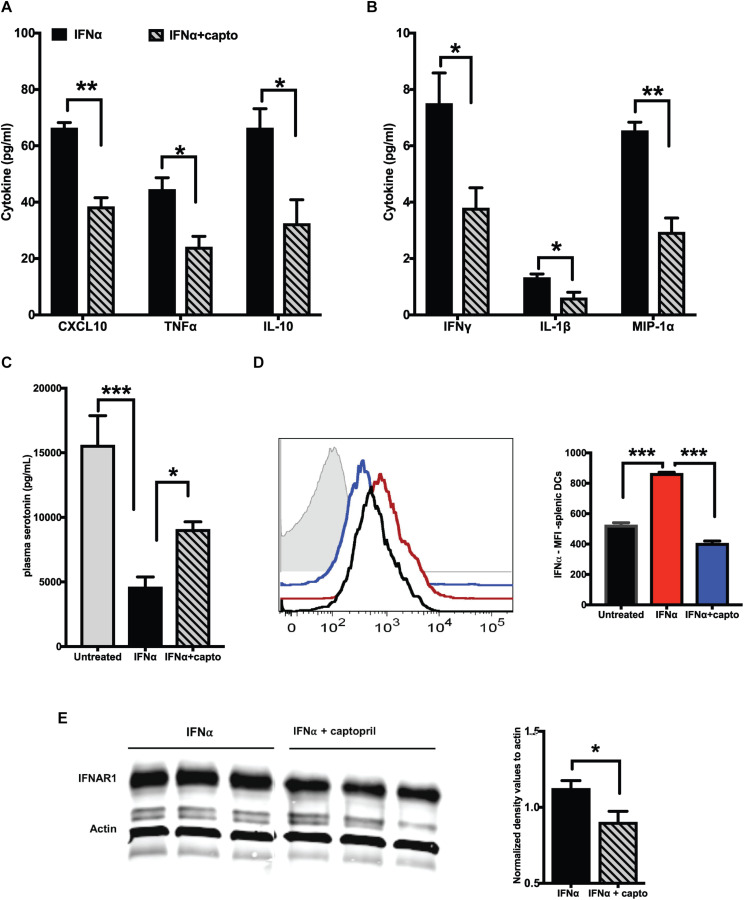
Captopril reduces IFN responsive protein expression. Plasma from MRL/lpr mice induced with exogenous IFNα and treated with captopril for 2 weeks were analyzed for cytokines and chemokines using MSD multiplex ELISA kit. Significantly different cytokines and chemokines are represented, (A) >10 pg/ml and (B) <10 pg/ml (n = 4/group). (C) Serotonin levels in plasma of IFNα induced MRL/lpr mice was measured using ELISA. (D) Splenocytes of IFNα treated MRL/lpr mice were harvested, stained for intracellular IFNα, gated and analyzed on CD11c + cells. Median fluorescence intensities (MFI) are represented as histograms on the left and the corresponding colors for the different groups indicated in the bar graph on the right (n = 4/group). Unstained control is shown in gray in the histogram. (E) Spleen lysates of exogenous IFNα treated MRL/lpr mice were analyzed by western blotting to detect IFNAR1 protein. Actin was used a loading control. Band intensities were analyzed using ImageJ software and normalized values are represented in the graph. Unpaired t test statistical analysis was performed and p < 0.05 was considered significant; *p < 0.05, **p < 0.01, and ***p < 0.001.